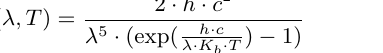
on earth. To simulate sub-pixel fires, a fraction of the observed area has an increased temperature. In Figure 4 a simulated spec- trum is depicted which shows emission of normal soil and soil with a fractional fire included, both observed after the atmo- sphere. The soil temperature is set to 300 K and the fire is es- timated to have a 1000 K temperature covering 1 % of the